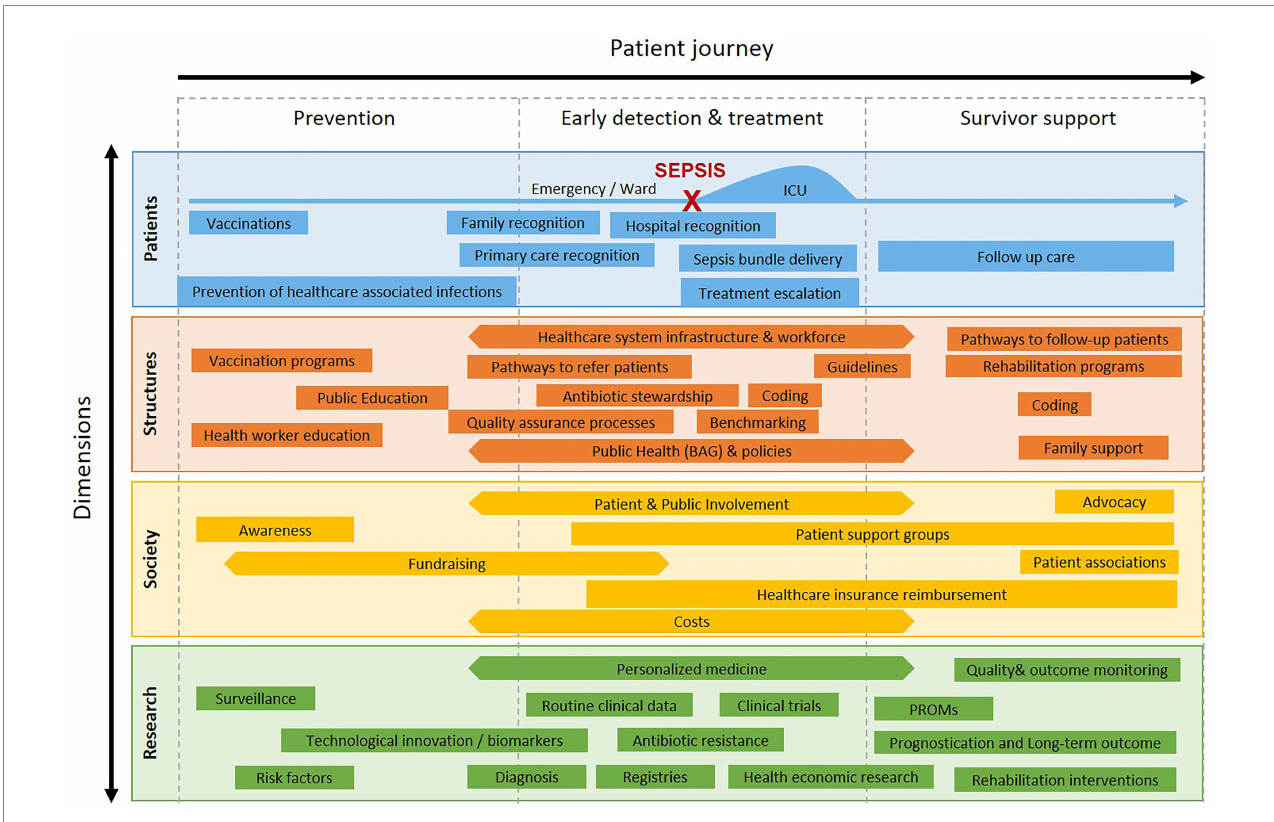
FIGURE 1 Overview on key topics identified by the Swiss Sepsis National Action Plan workshop, across the patient journey in relation to patient, structure, society, and research